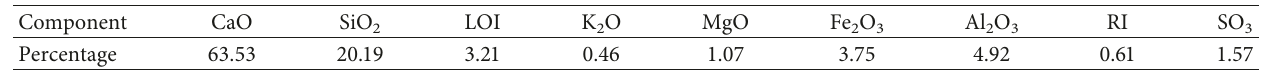
Table 3: Chemical composition of cement.